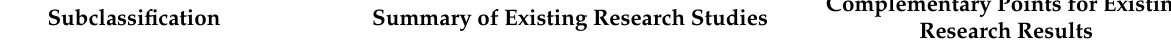
Table 3. Summarized trends survey table of value assessment